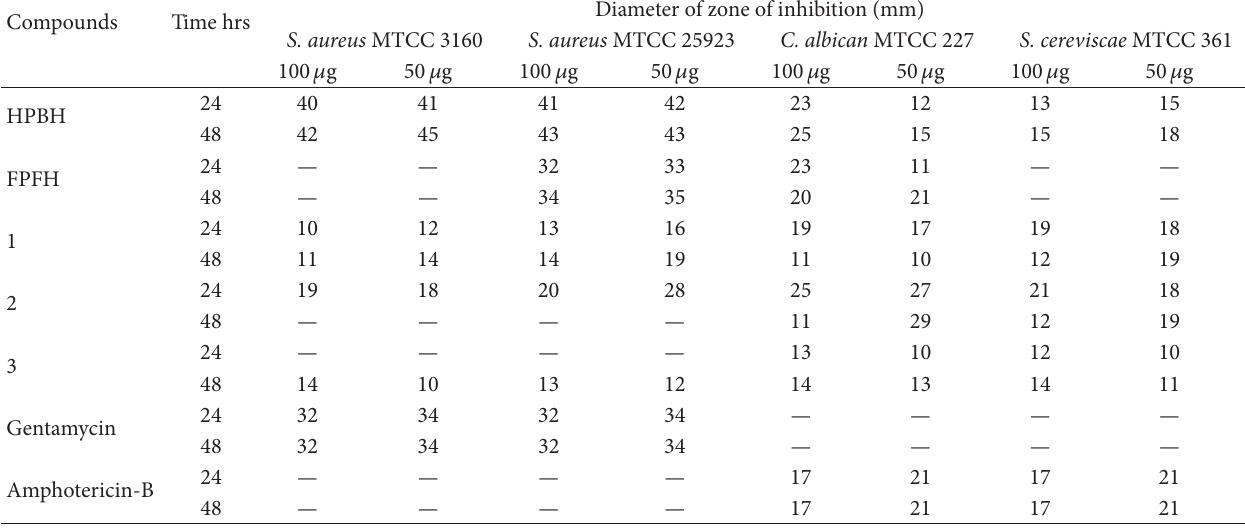
T 2: Antimicrobial activity of hydrazones ligand and their metal complexes.